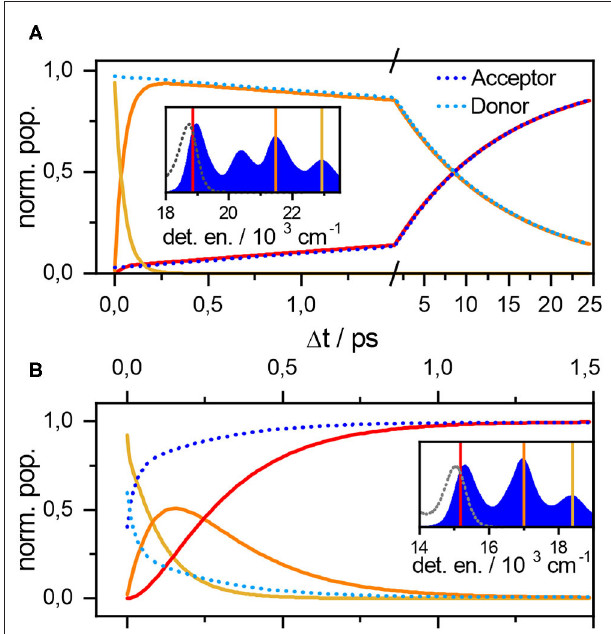
FIGURE 3 | Population evolutions for the orthogonal (A) and parallel (B) dyad. Parameters are the same as for Figure 2 . Population evolution of donor (light blue), acceptor (dark blue) states as well as populations of resonant levels around the color-coded energies. The inset shows these energies with respect to the absorption (full blue area) and emission spectrum (gray dashed lines).